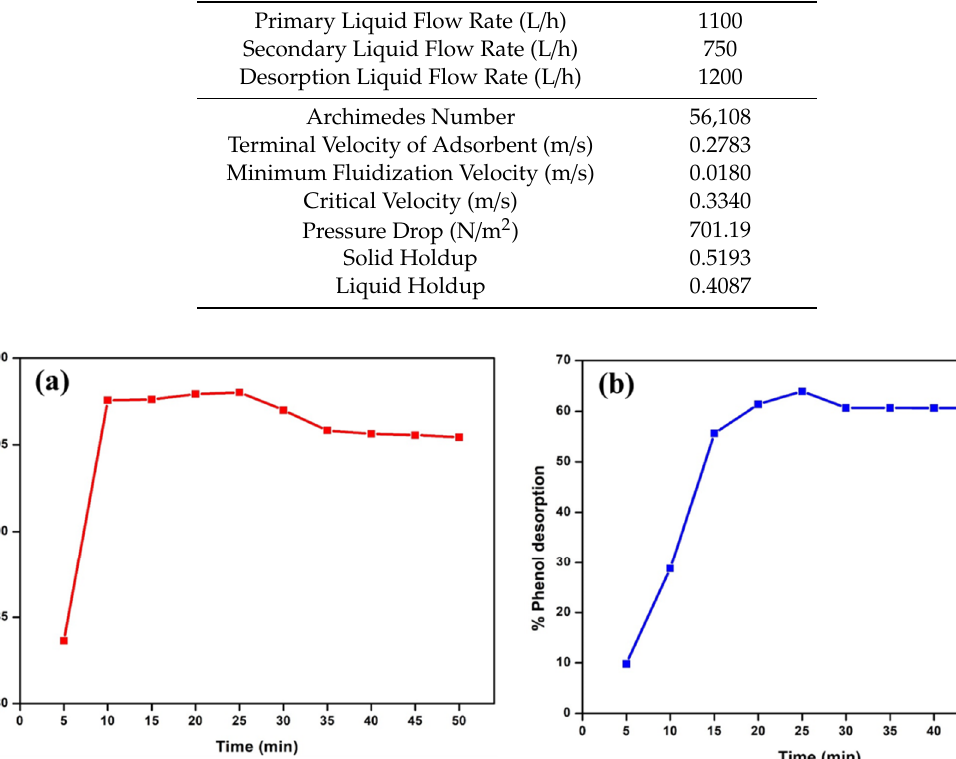
Table 2. Operational parameters for the liquid-solid circulating fluidized bed (LSCFB) column.